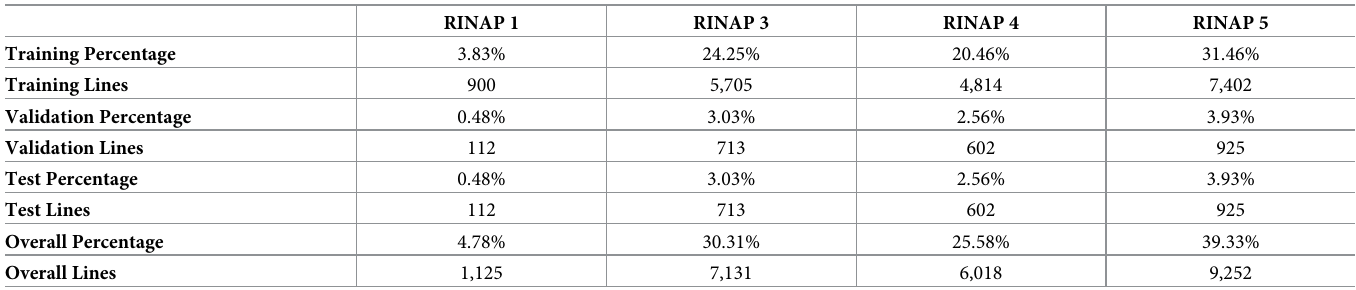
Table 1. Breakdown of RINAP